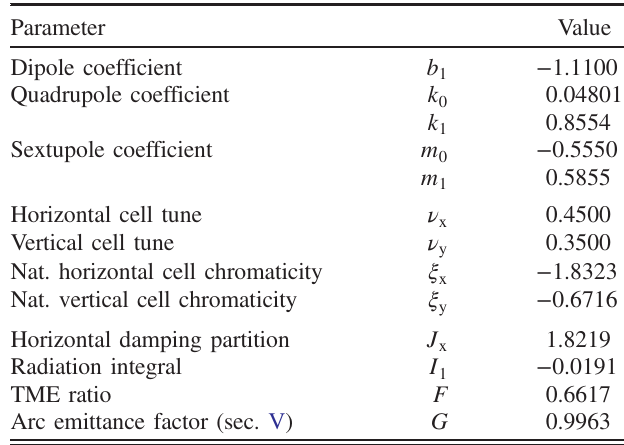
TABLE I. Example multipole parameters of a Mathieu cell and its figures of